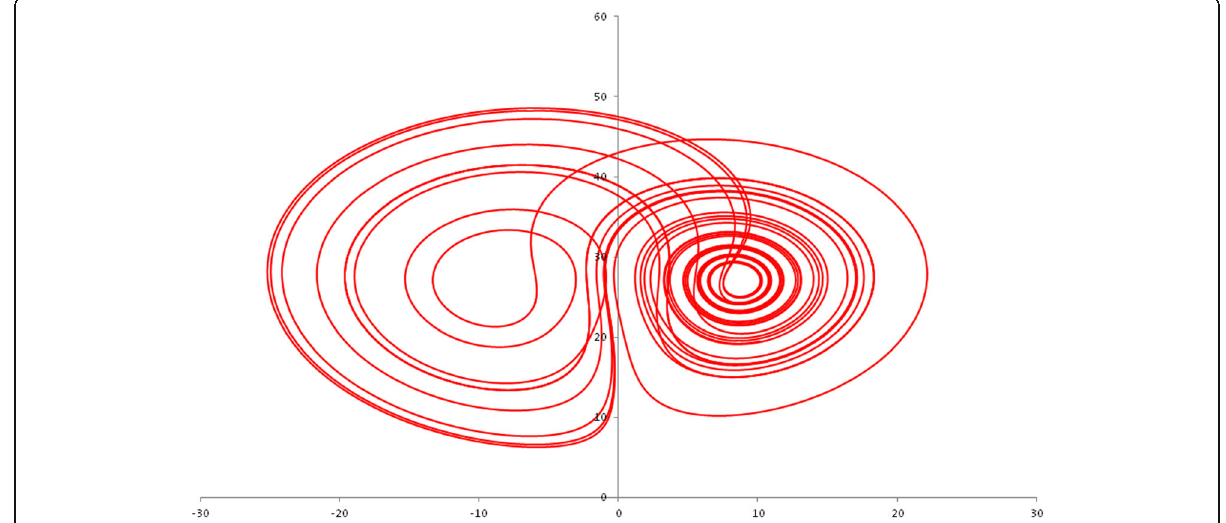
Fig. 6 Attractor for the Lorentz system, x 2 plotted against x